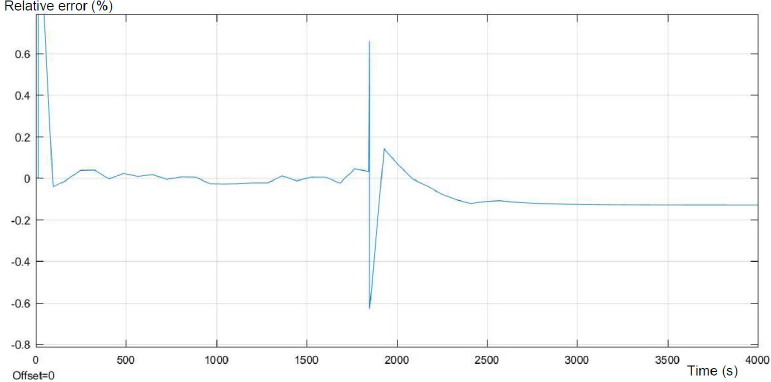
Figure 13. Relative error of the